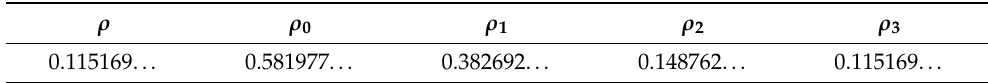
Table 3. Radius for Example